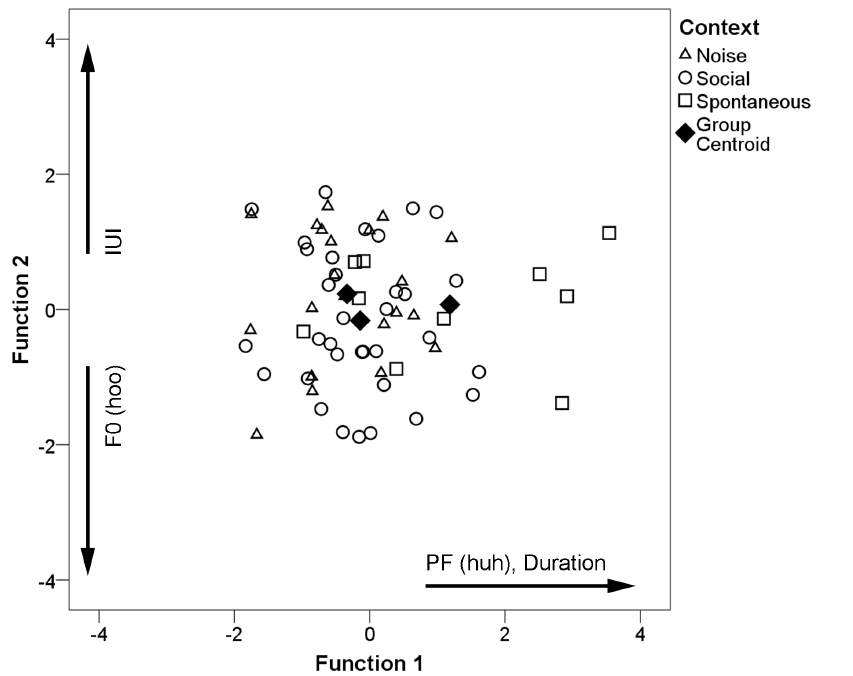
Figure 3. Discriminant scores for loud calls produced in different contexts for the first two canonical discriminant functions. The three contexts are denoted by different symbols. Variables showing loadings with an absolute value . 0.4 for each function are indicated along the axes.